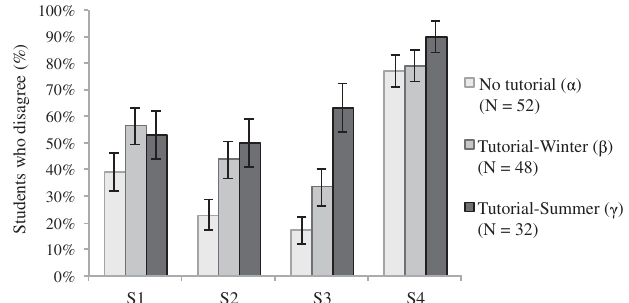
FIG. 5. The percentage of students by category ( α , β , or γ ), who answered each statement correctly. Error bars indicate the ffiffiffiffiffiffiffiffiffiffiffiffiffiffiffiffiffiffiffiffiffiffiffiffi p p ð 1 − p Þ =N standard error on a proportion [